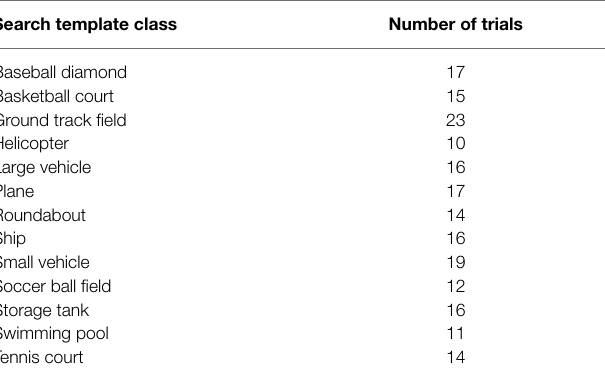
each target instance in the image, regardless of whether they had selected the instance or not. Prior to the search task, participants saw the same training trials as in Experiment 1. TABLE 3 | Number of trials for each search template class in Experiment 2. Search template